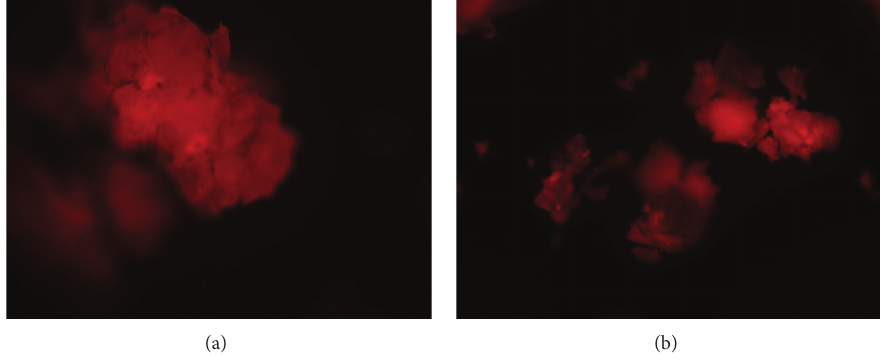
Figure 6: Microscopy images ( × 10) of the fluorescent: (a) Ny 66- o -NH 2 and (b) Ny 66- p -NH 2